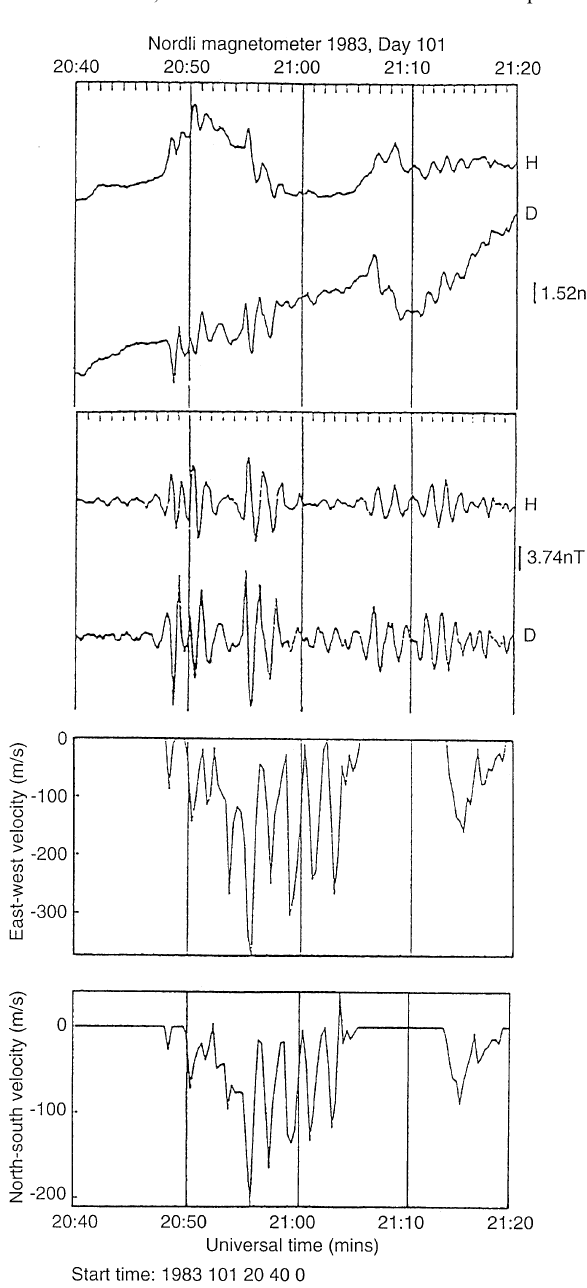
Fig. 6. Time series data for the Pi2 pulsations present on day 101, 1983. From top to bottom , unfiltered and filtered ground mag- netometer data from Nordli are presented together with SABRE east-west and north-south velocity component data. The SABRE data were averaged over the small region of backscatter present during the event, from 66 ° to 67.6 ° N and 4 ° at 6 °